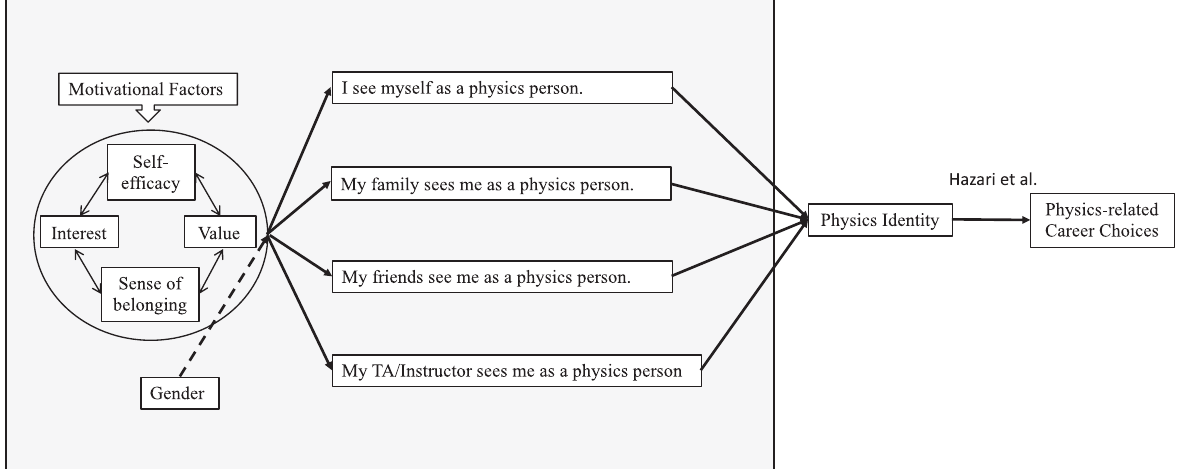
FIG. 1. Schematic representation of gendered relationships of four motivational factors to the components of physics identity (internal and external), which has been previously linked to career choices [33]. While “ I see myself as a physics person ” represents the “ internal ” aspect of physics identity, the other three Physics Identity items related to others ’ recognition (perception of my family, my friends, and my TA or instructor ’ s views) represent students ’ “ external ” physics